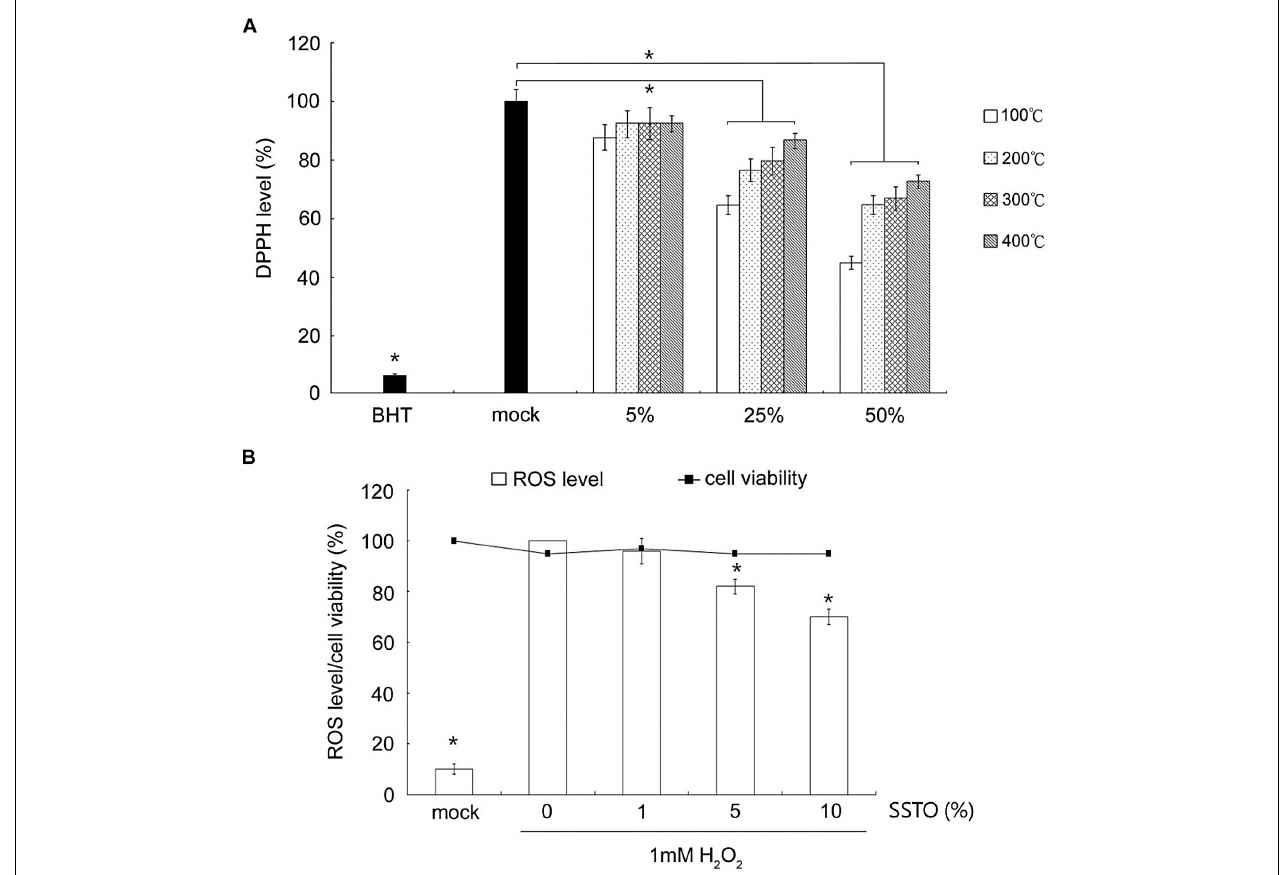
FIGURE 2 | Antioxidant activity of SSTO. (A) DPPH assay. The y -axis shows the relative percentage of the residual DPPH level as compared with butylated hydroxytoluene (BHT) as the positive control. The x -axis shows the positive and negative controls and SSTO samples at different concentrations prepared at various rendering temperatures. (B) Cellular ROS assay. RAW264.7 cells were incubated with SSTO, and the percentage of ROS reduction in the culture was measured. Cell viability was also monitored by MTT assay. *Statistically significant difference as compared with the non-SSTO treated group, but with 1 mM H 2 O 2